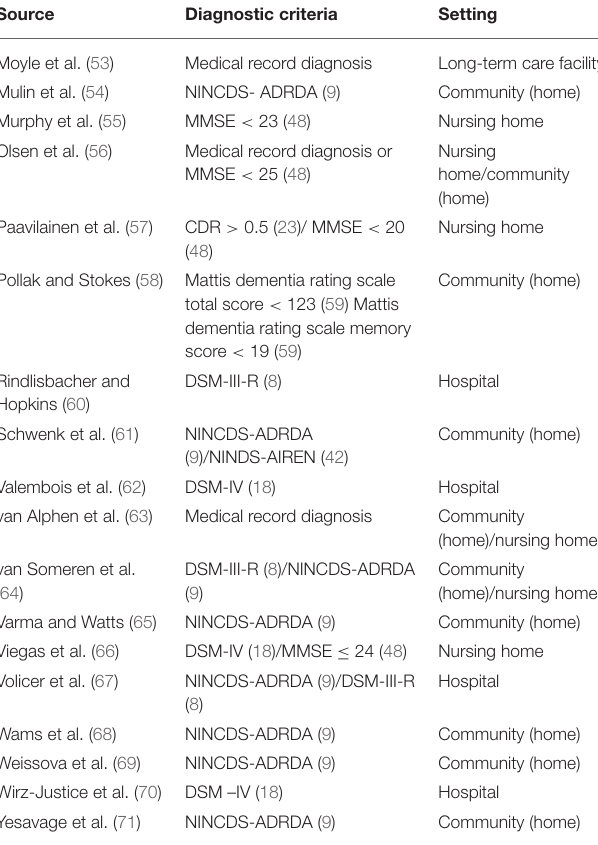
TABLE 1 | Patient setting and diagnostic criteria for 48 observational studies testing wearable technology in participants with